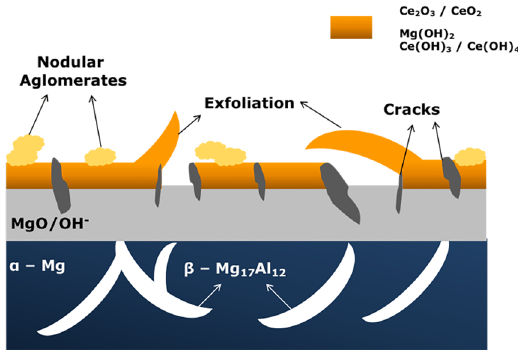
Figure 9. Cerium conversion coating formation illustration.